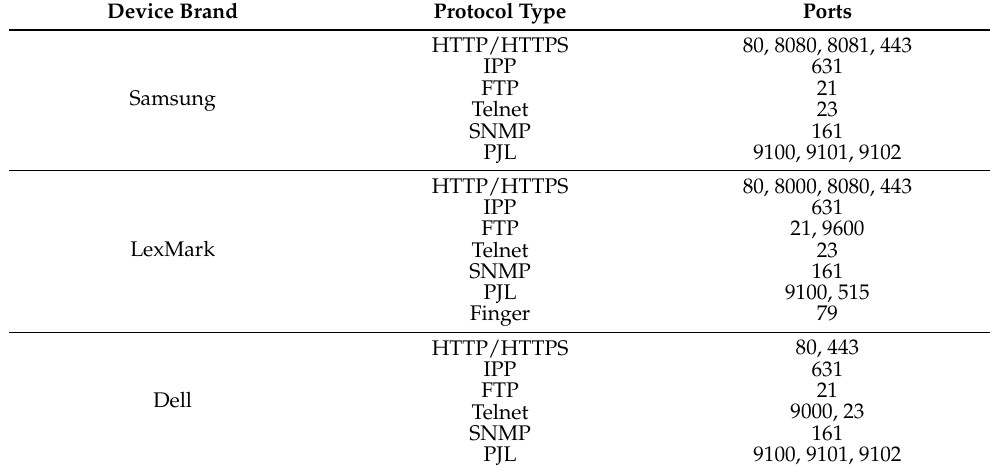
Table A4. Special Port For